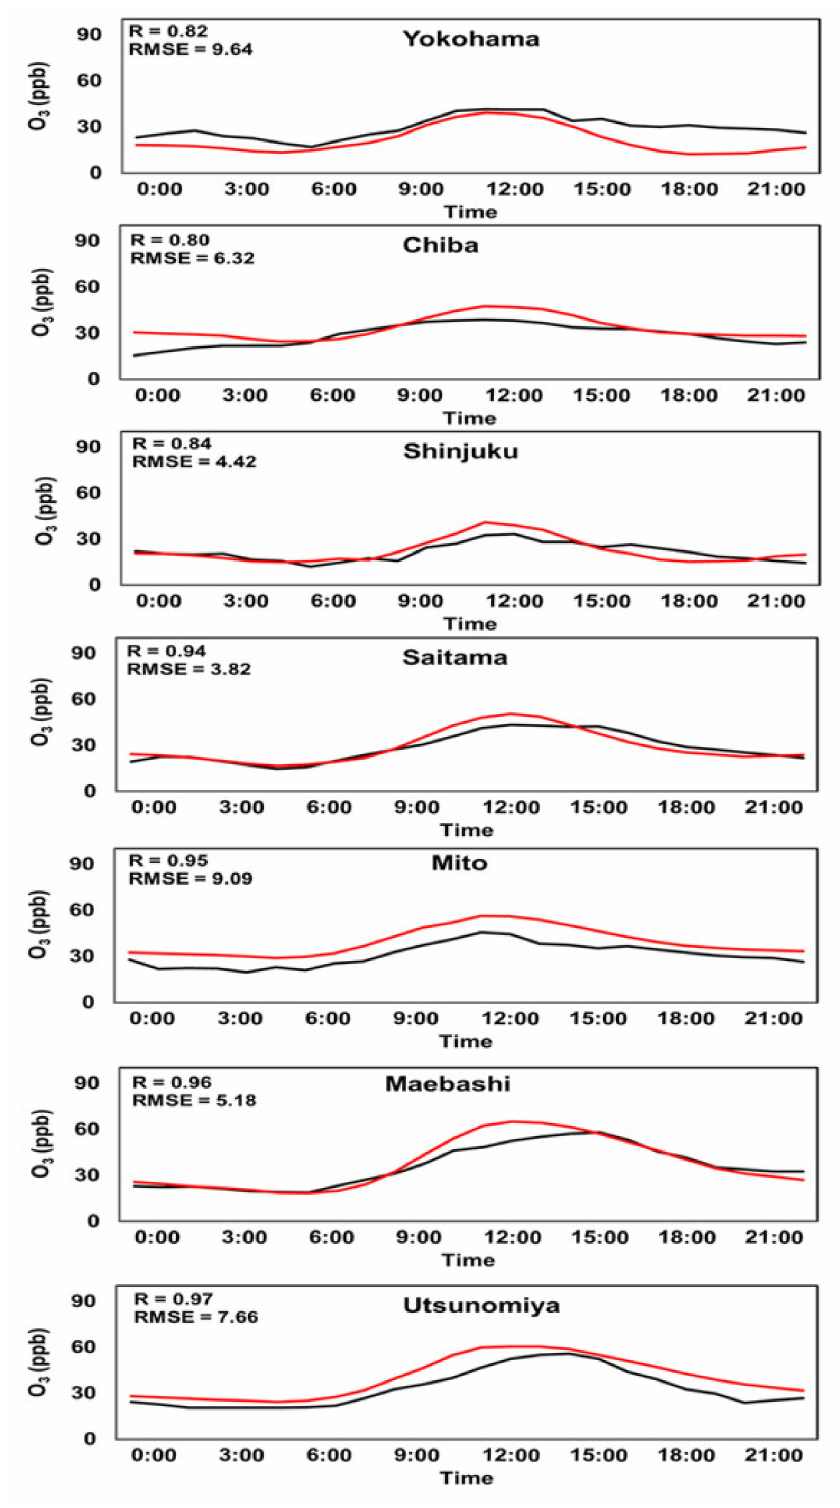
Figure 3. Observed ( black line ) and modeled ( red line ) average hourly ozone (O 3 ) concentrations during the 2016 ozone season in seven regions of